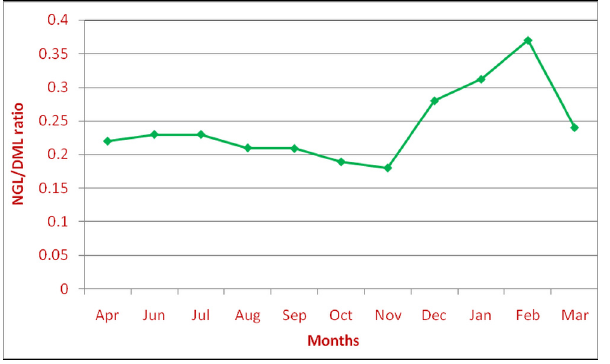
Fig. 8. Size at first maturity of males and females of S.